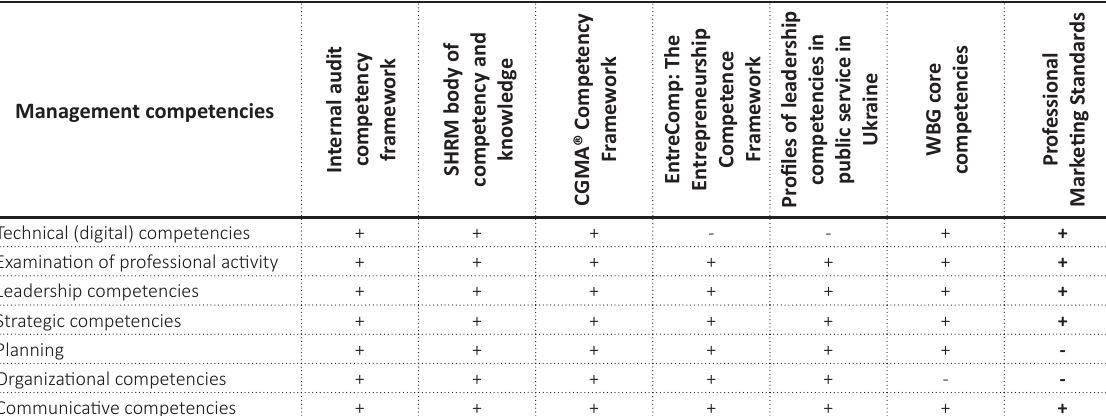
Table A1. Comparison of managerial competencies relevant in the labor market and declared in international standards